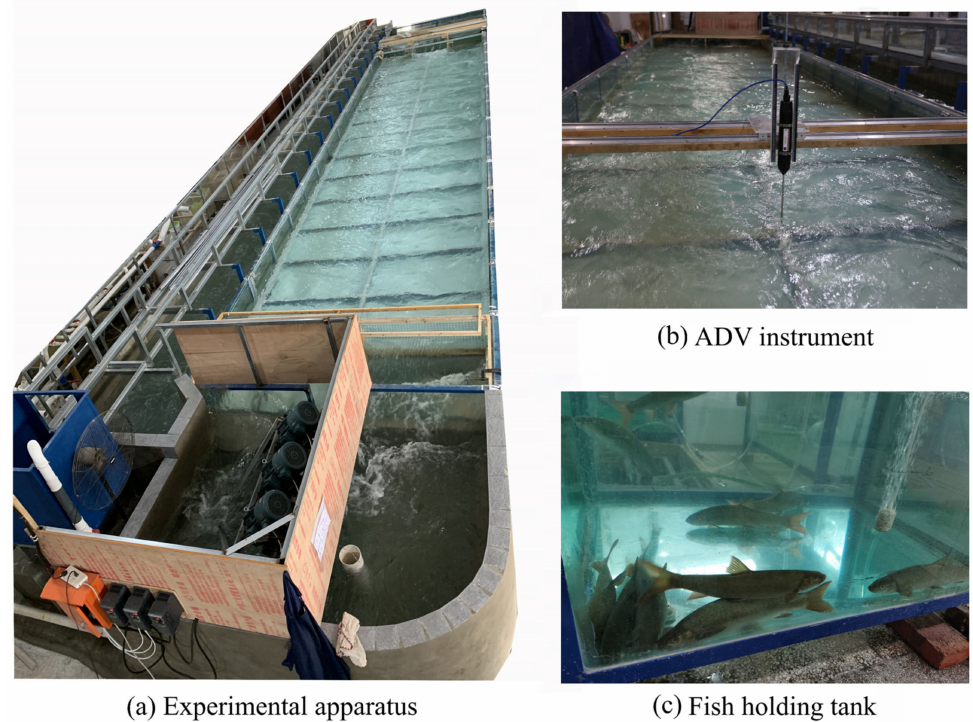
Figure 1. Real device: ( a ) experimental apparatus in the State Key Laboratory of Hydraulics and Mountain River Engineering of Sichuan University, ( b ) Acoustic Doppler Velocimeter (ADV) instru- ment, and ( c ) Schizothorax prenanti holding